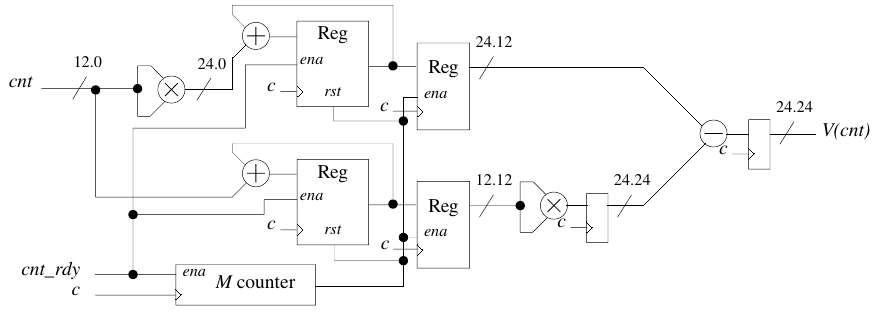
Figure 11: Implementation of the counter variance measurement circuitry for the method proposed by Haddad et al. in [HBFT14] and for that corresponding to Eq. (2) Again, all the computations are in fixed point arithmetic. Numbers before and after the radix point indicate the number of bits of the integer and fractional part of the given value, respectively. Two multipliers (one of 12 bits and the other of 24 bits) are used to square data. Two adders and associated registers (one of 24 bits and the other of 12 bits) are used to implement accumulators. One subtractor is used before the output of the block. Four additional data registers are used to store intermediate